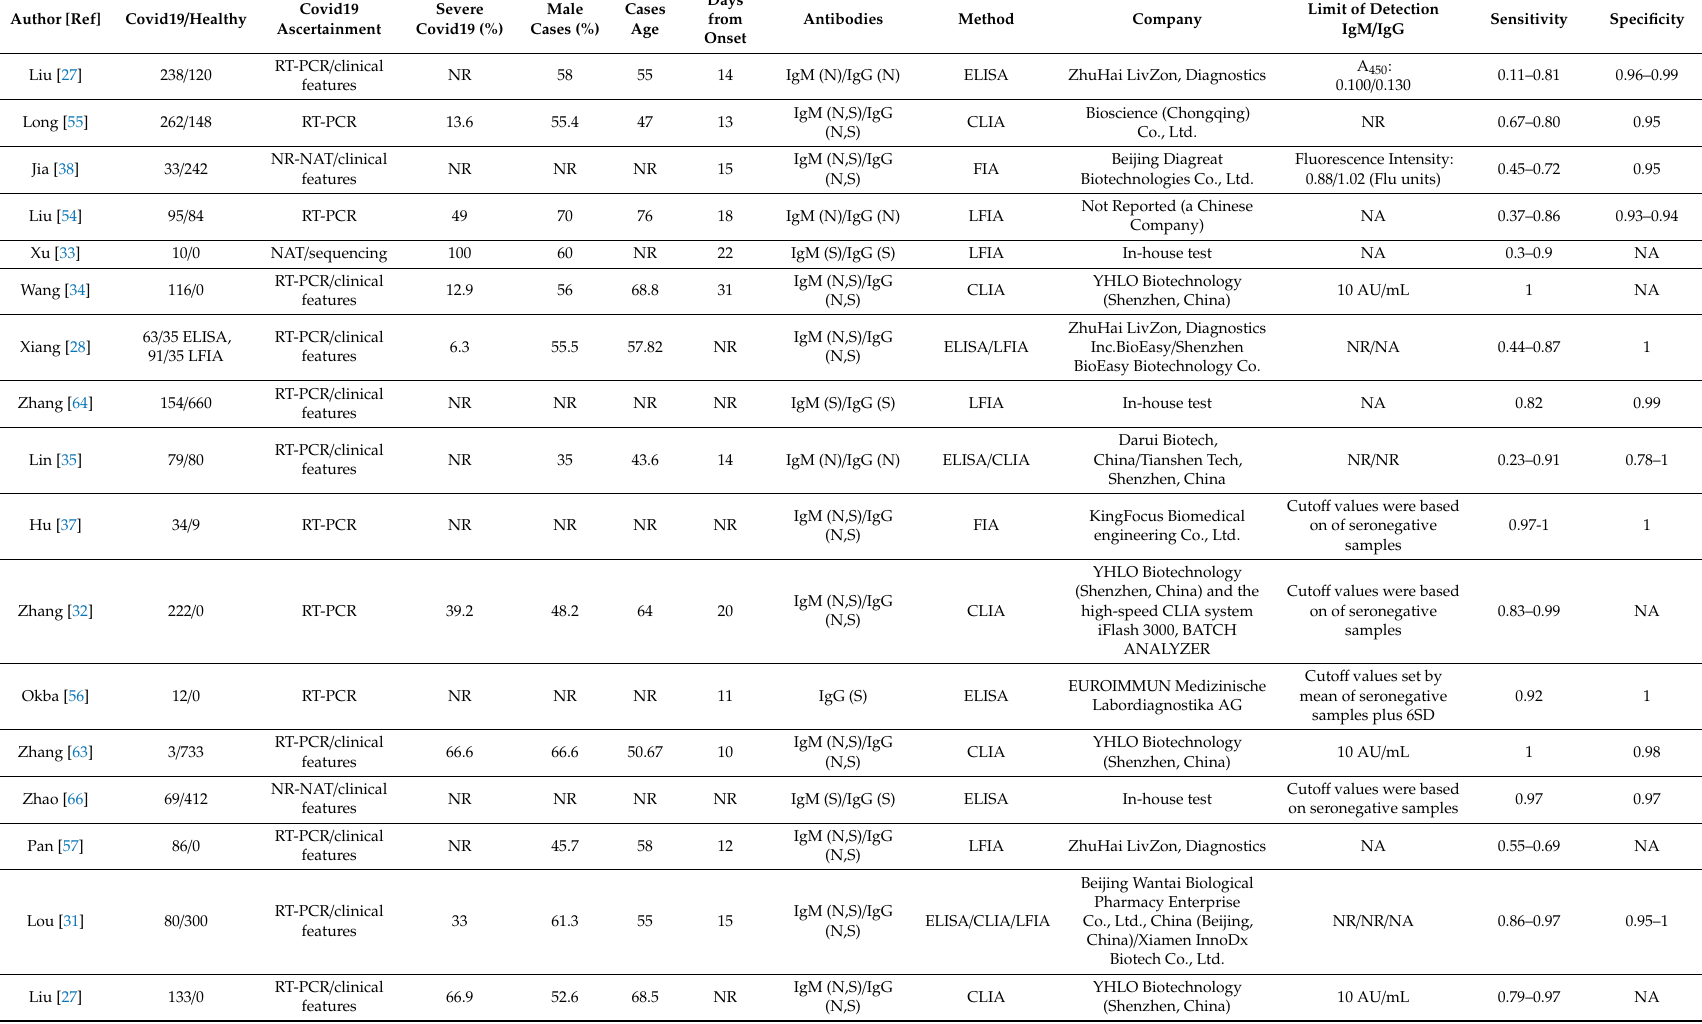
Table 1. Characteristics of the 38 studies included in the meta-analysis.